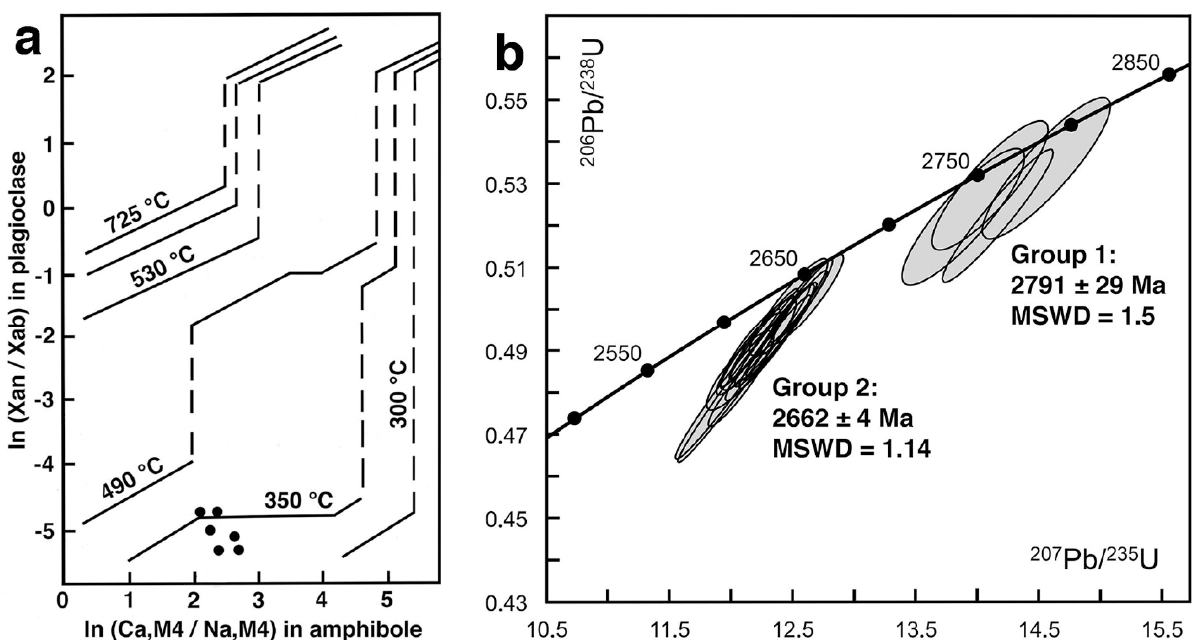
Figure 9. Temperature estimates and U-Pb zircon age of the Albite-Actinolite Porphyry. ( a ) Diagram showing the NaSi-CaAl exchange equilibria of ln(Xan/Xab) plagioclase and ln(Ca,M4/Na,M4) amphibole (after [40]). The mineral pairs (black dots) from albite-actinolite altered porphyries (samples HB-8a and -8b; Table S2) plot between the 300 ◦ C and 350 ◦ C contour lines ( ± 25 ◦ C). ( b ) U-Pb Concordia diagram of SHRIMP ion-microprobe spot analyses in zircons from the Albite-Actinolite Porphyry (sample HB-8a; Table S3). The concordant data ( ≤ 5% discordant) of the single xenocryst define a weighted mean 207 Pb/ 206 Pb age of 2791 ± 29 Ma (Group 1: n = 4), and those of igneous crystals a 207 Pb/ 206 Pb age of 2662 ± 4 Ma (Group 2: n = 16). The error ellipses are 1-sigma.